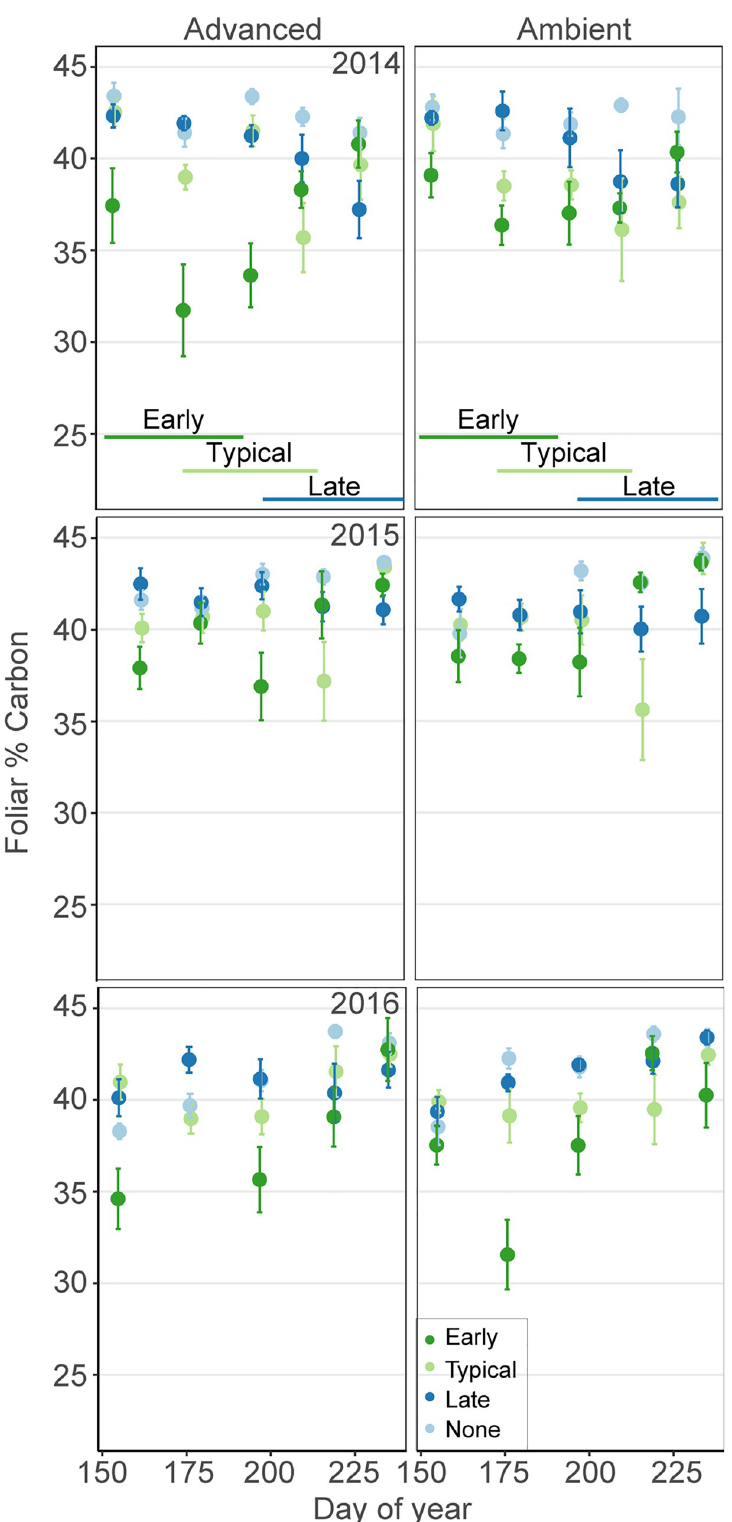
Fig 4. Foliar percent C. Mean percent C ( ± 1 SE) for treatment plots across the growing season from 2014–2016 (n = 6 replicates/treatment). Treatments included advanced and ambient growing seasons, and early, typical, late and no grazing. Lines on the bottom show the timing of the early, typical and late grazing treatments.